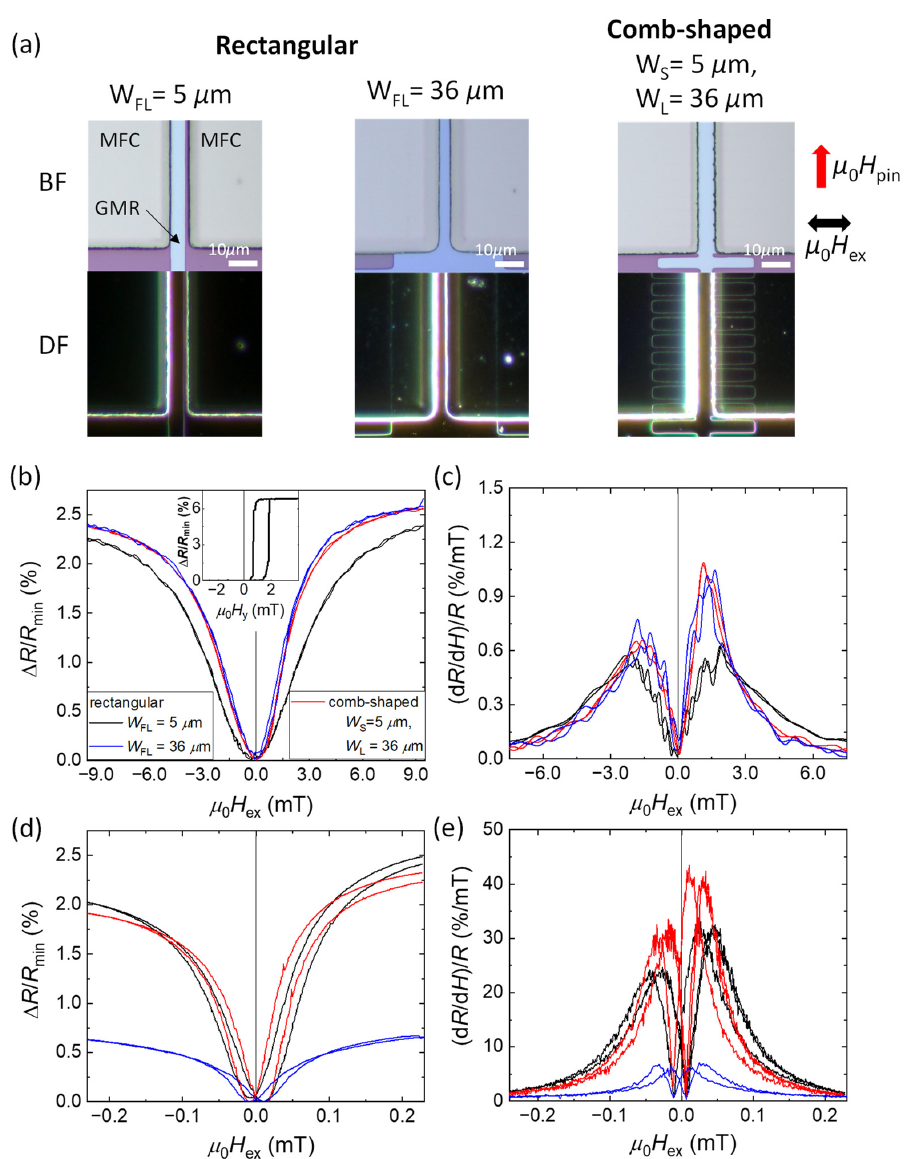
Figure 7. ( a ) Bright field (BF) and dark field (DF) optical microscope images of the rectangular SV with W FL = 5 μ m and 36 μ m, and the comb-shaped SV with W S = 5 μ m and W L = 36 μ m. ( b ) Δ R / R min and ( c ) (d R /d H )/ R of the three sensors measured without MFCs. Inset in ( b ) is the Δ R / R min curve of a rectangular SV with W FL = 5 μ m for an external magnetic field μ 0 H y in the y -direction, i.e., parallel